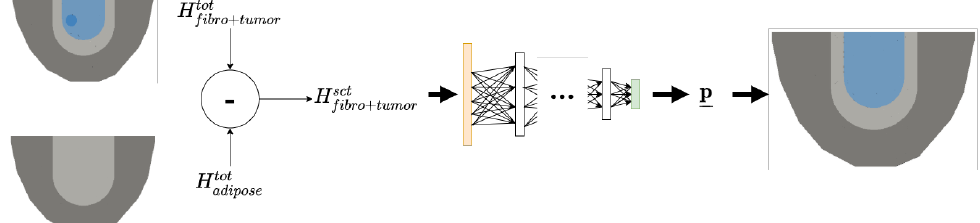
Figure 4. The Stage 1 bulk parameter inference network accepts breast-target data which may include a tumor, and outputs the bulk fibroglandular